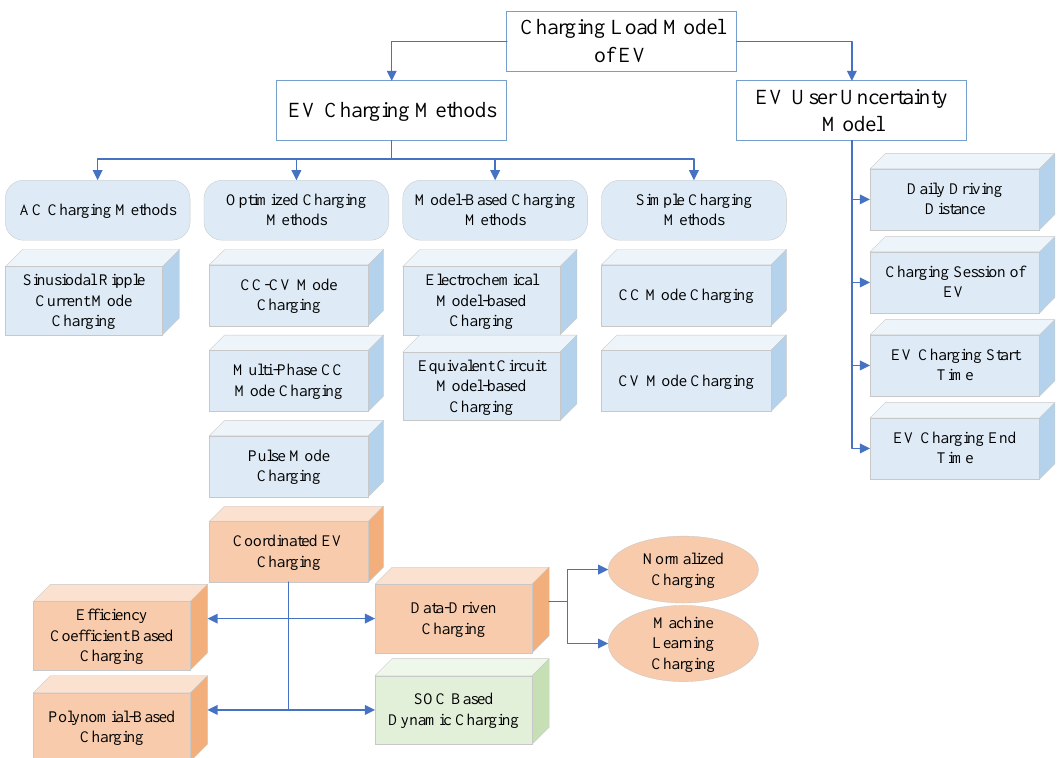
Figure 1. Types of EV charging load modeling (blue boxes = existed methods, orange boxes = newest methods, green box = the proposed method in this